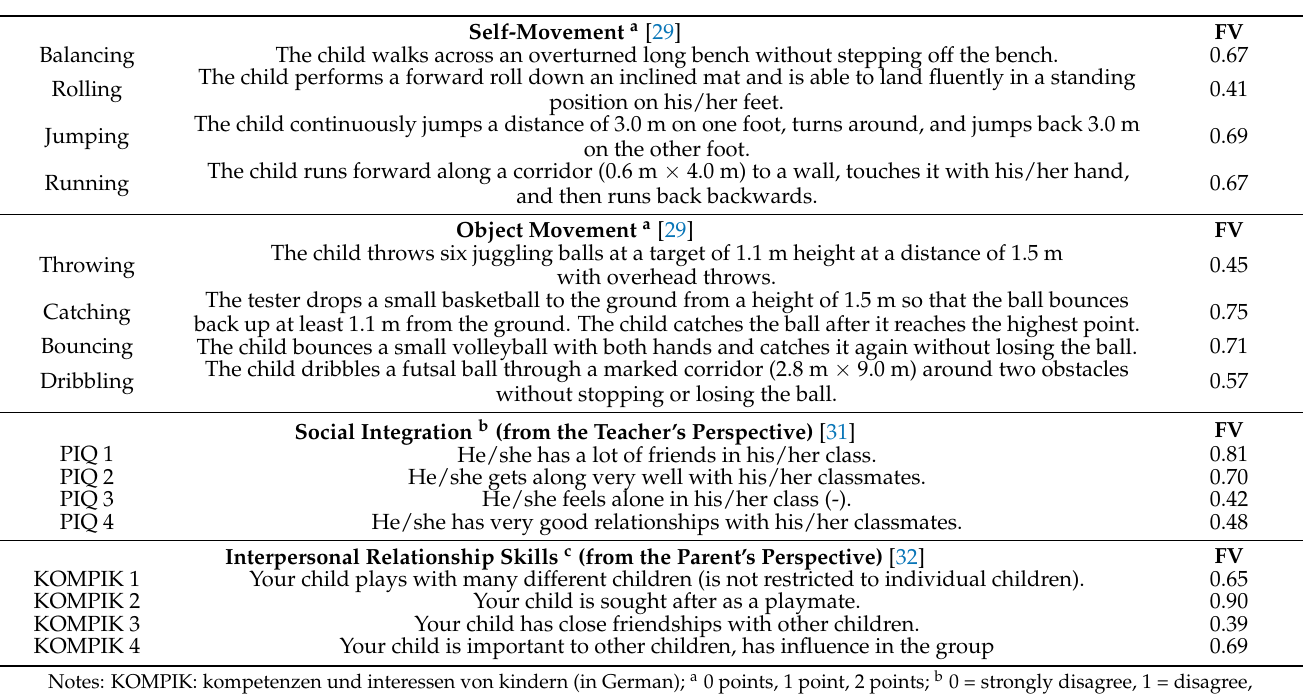
Table 1. Description of the test items and their factor values (FV) in model 1. PIQ: perception of inclusion. Self-Movement a [29] FV Balancing The child walks across an overturned long bench without stepping off the bench.